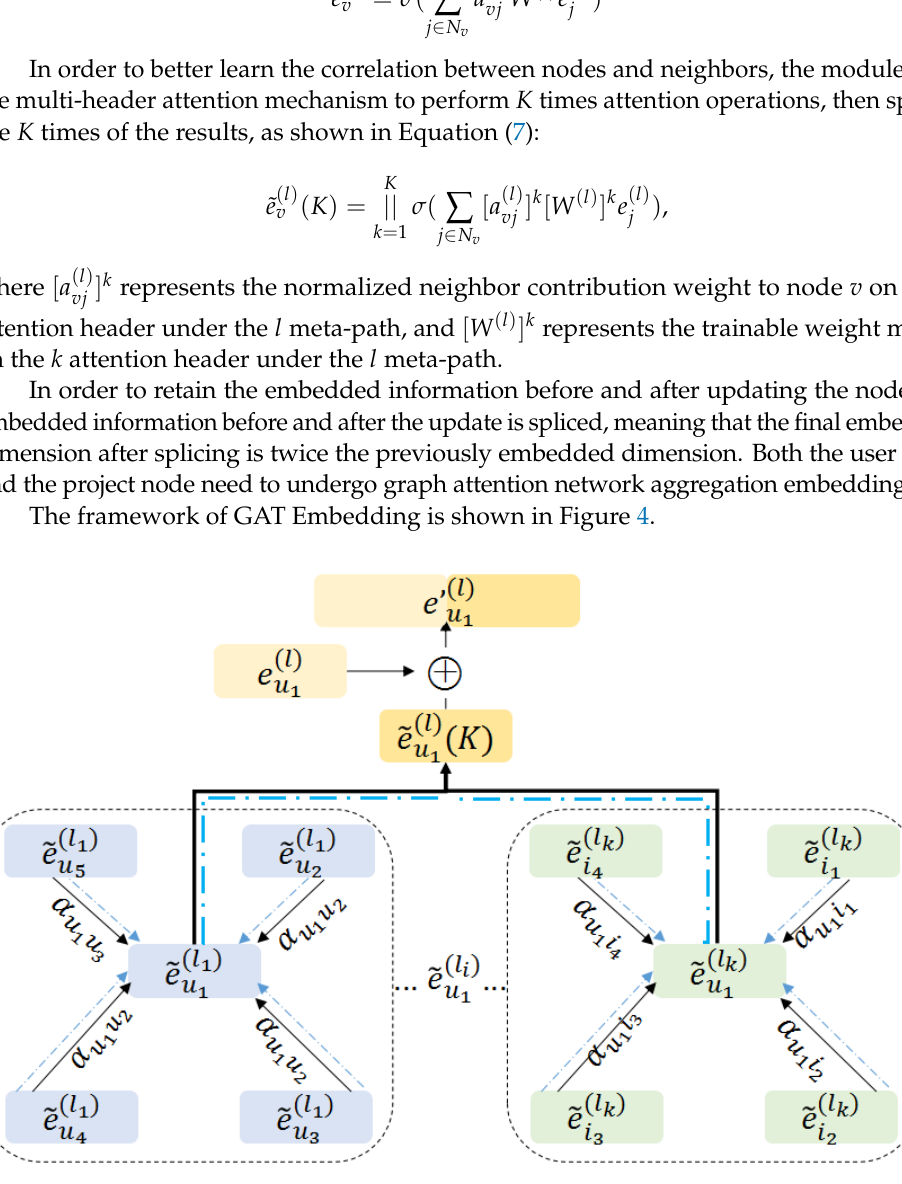
Figure 4. Framework of GAT